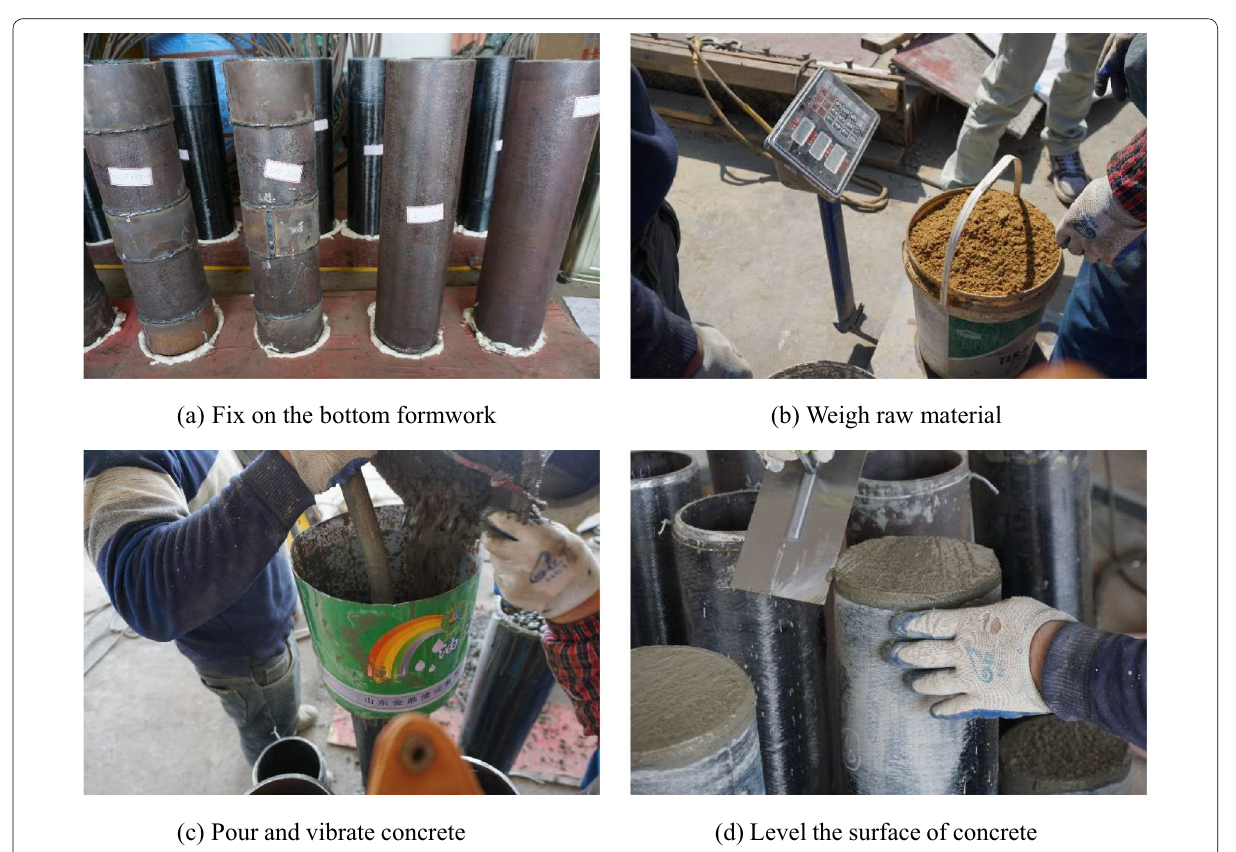
Fig. 6 Process of pouring